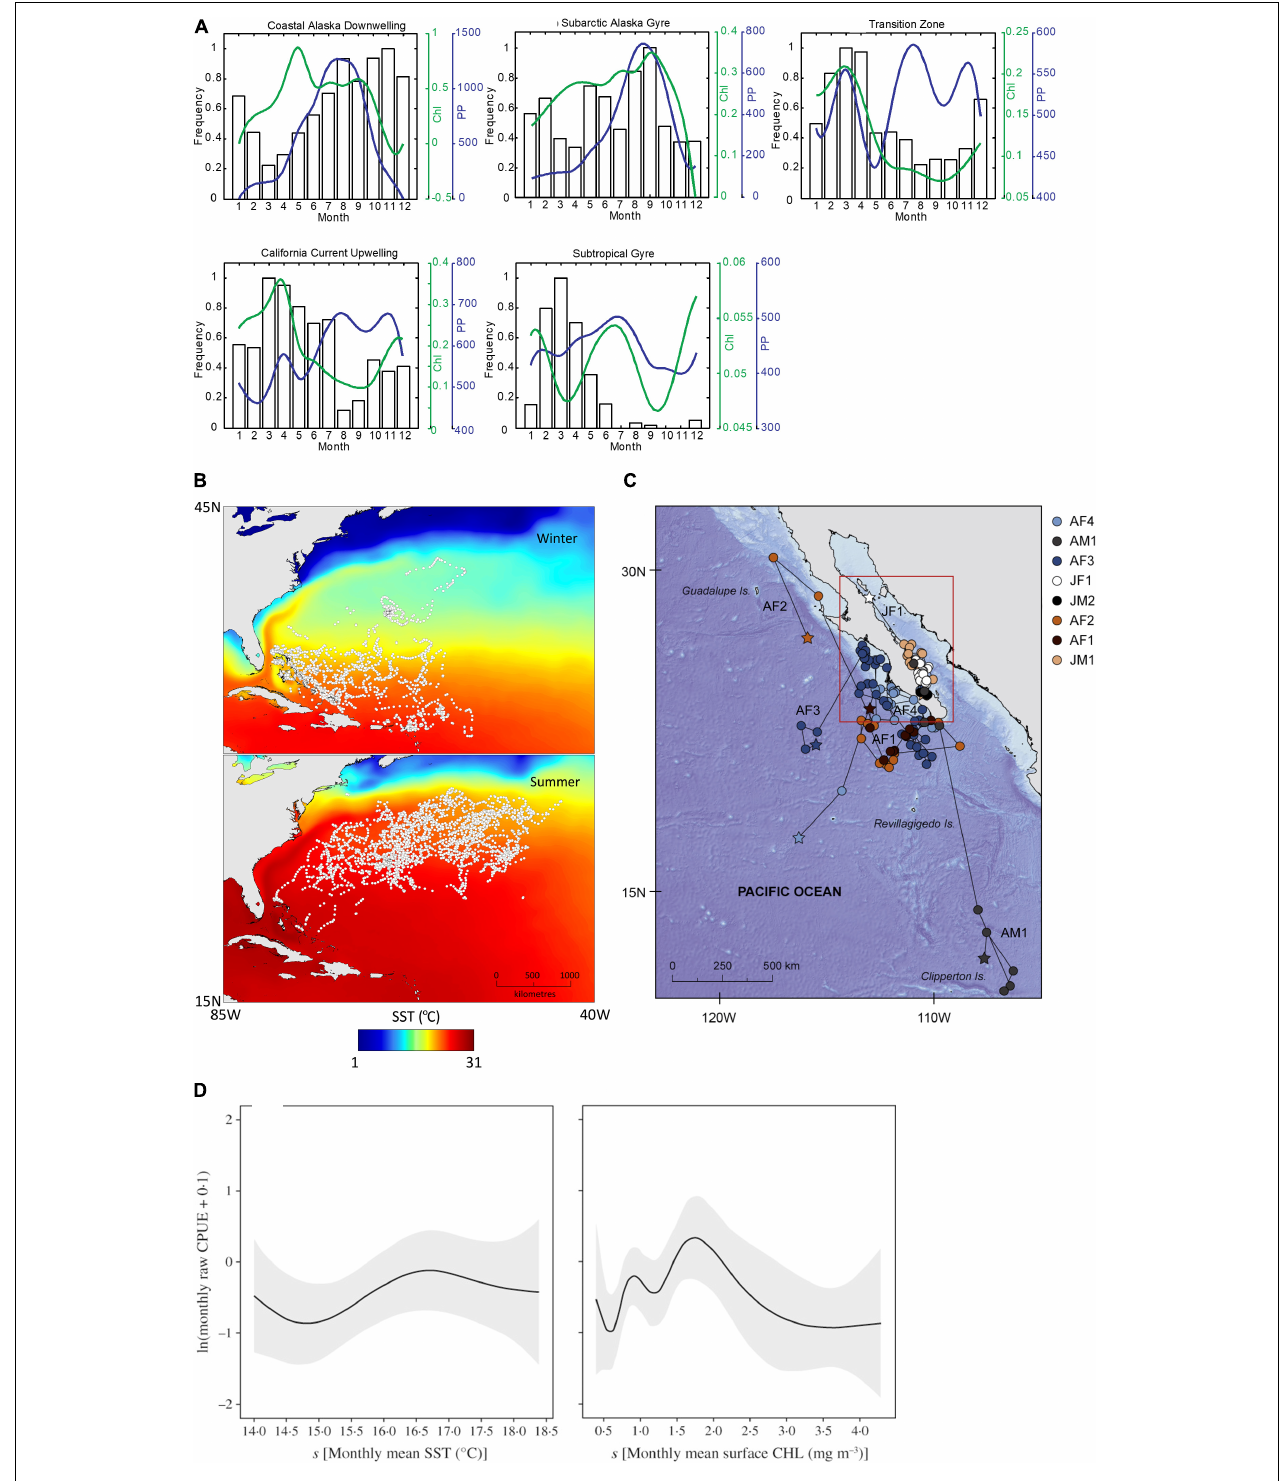
FIGURE 3 | Example uses of SRS in elasmobranch research themes. (A) Seasonal utilization of foraging regions for migrating salmon sharks, Lamna ditropis , compared to monthly median cholorophyll- a (Chl) concentration and primary production (PP) (Weng et al., 2008). (B) Geolocations of tiger sharks, Galeocerdo cuvier , between winter and summer, overlaid on mean seasonal SST (Lea et al., 2015). (C) Geolocated tracks of whale sharks, Rhincodon typus , reconstructed using remotely sensed SST (Ramírez-Macías et al., 2017). (D) Monthly mean sea surface temperature (SST) and monthly mean surface chlorophyll a concentration (CHL) and blue shark, Prionace glauca , catch per unit effort (CPUE, total number fish caught per total number fishing trips) (Mitchell et al., 2014).